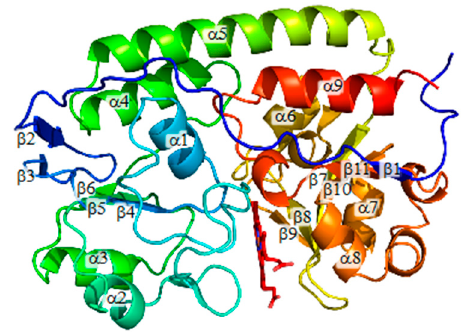
Figure 1. Overall structure of HmuT from Corynebacterium glutamicum (CgHmuT).